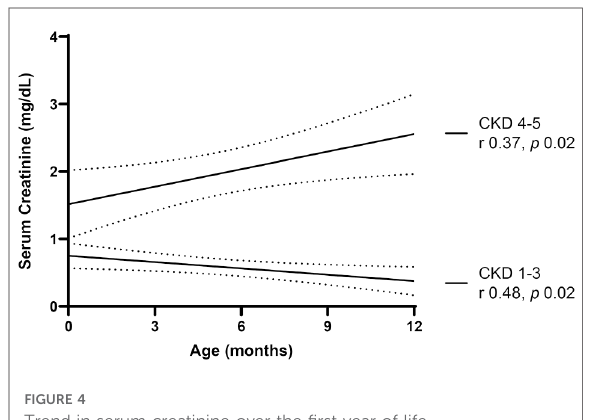
FIGURE 4 Trend in serum creatinine over the fi rst year of